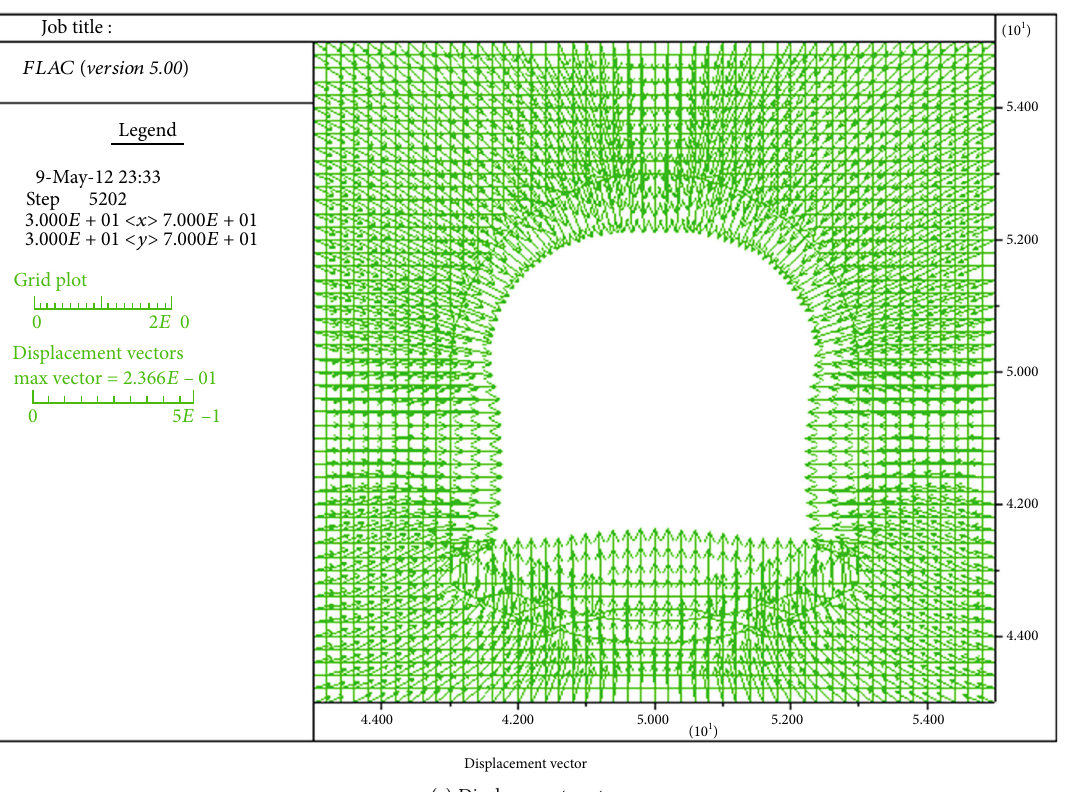
Figure 12: Movement rule of surrounding rock in a restoration